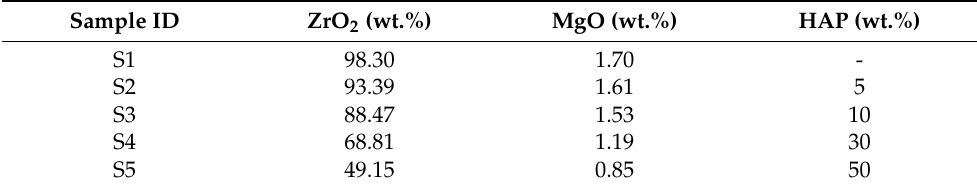
Table 1. The nominal composition (wt.%) and notation of the